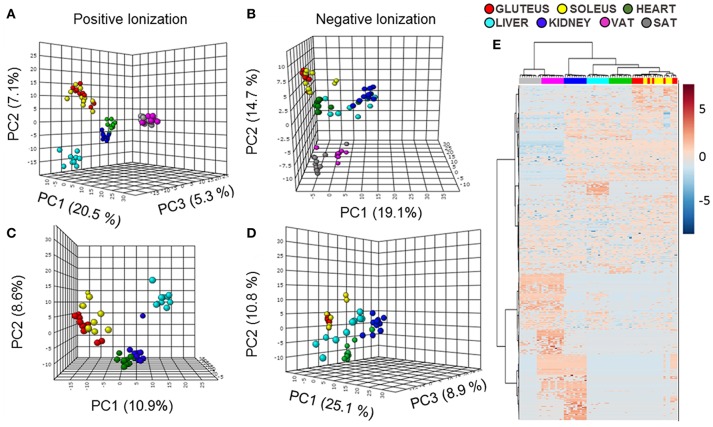
Multivariate statistics reveal a specific lipidomic profile for each tissue. (A,B) Principal component analysis (PCA) representation of the lipidome of all the tissues in positive and negative ionization polarities. (C,D) PCA representation of the lipidomic profiles of all the tissues except for both type of adipose tissues in positive and negative ionization polarities. X: Principal component 1 (PC1), Y: Principal component 2 (PC2), Z: Principal component 3 (PC3). (E) Hierarchical clustering algorithm represented by a heat map of the lipid species detected in both polarities of ionization in all the tissues.